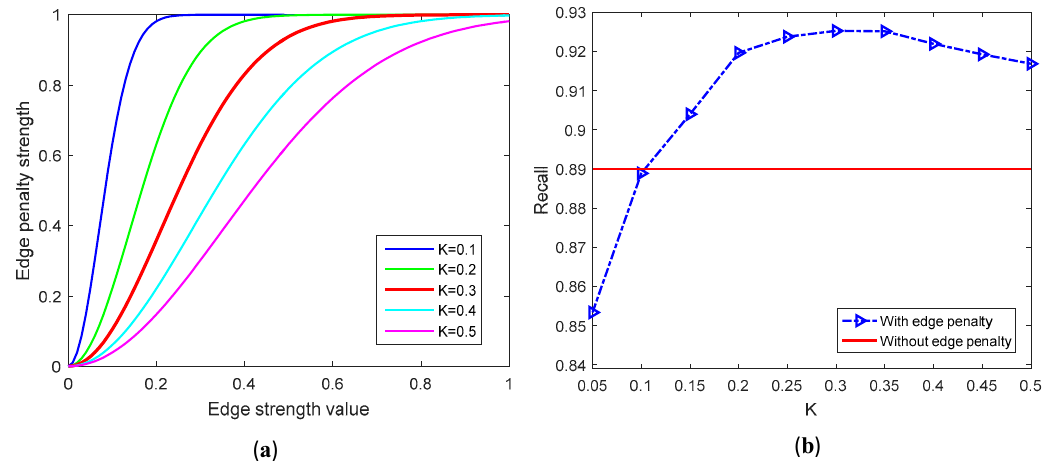
Figure 5. ( a ) Edge penalty strength of a single pixel; ( b ) Recall curve with different 𝐾 value.